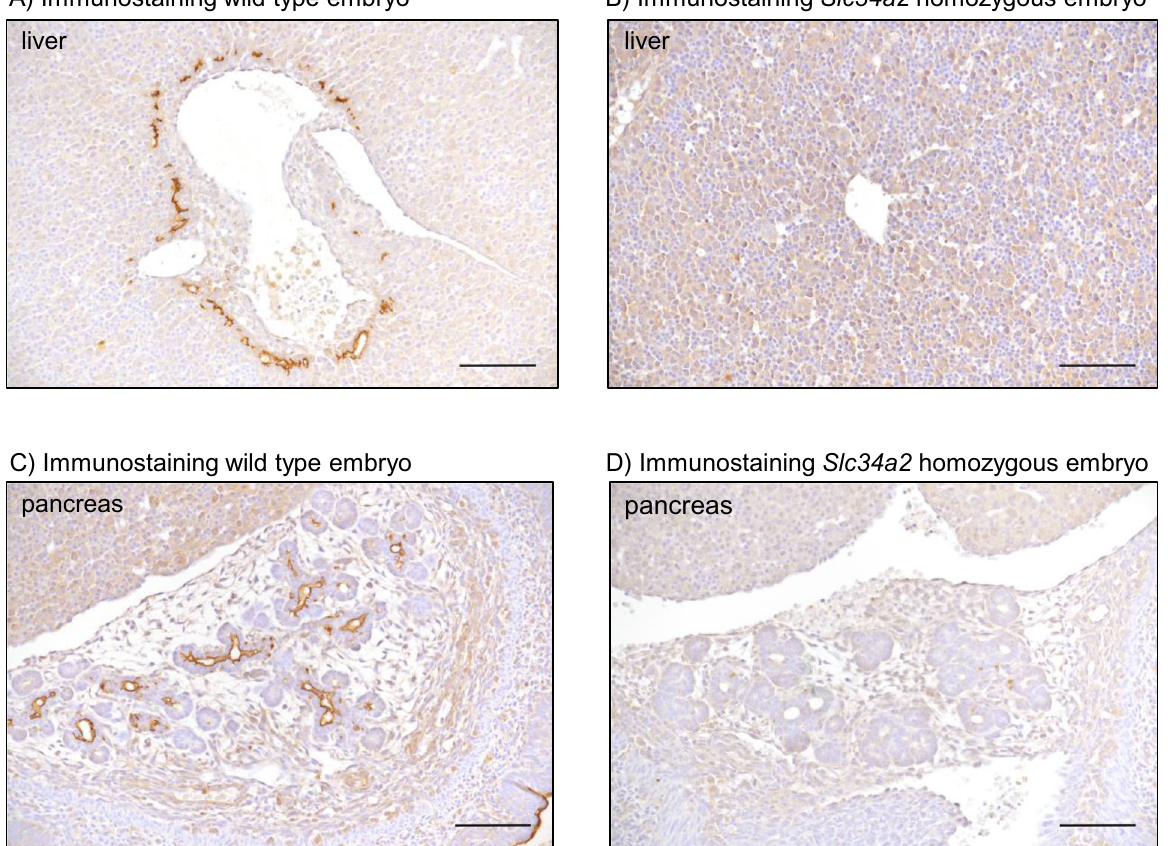
Figure 8. Liver ( A , B ) and pancreas ( C , D ) from wild type ( A , C ) and Slc34a2 homozygous E18 embryos ( B , D ) stained with a NaPi-IIb antibody. Scale bars: 50 µm.